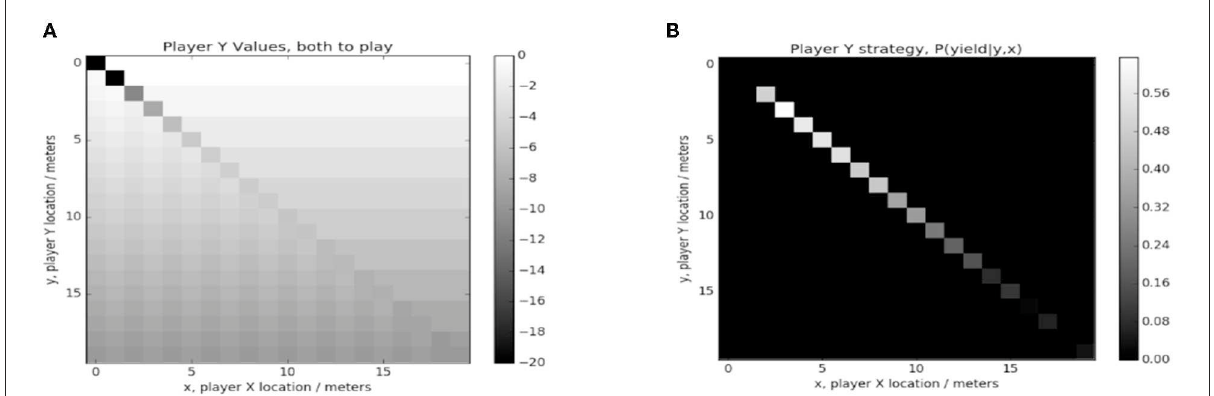
FIGURE4 (A) Value function for player Y over agent joint distance ( x , y ) states up to 20 meters of each agent from the collision point. All values are negative as they include components from cost of time needed to reach the destination and the risk of collision occurring. The collision state x = y = 0 is shown in the top left and has the worst value. Player Y arriving at their destination occurs along the rest of y = 0 and has the best value. (B) Player Y’s strategy over agent joint distance ( x , y ) states up to 20 meters of each agent from the collision point. For each state, Y ’s best strategy is to yield to Player X (i.e., slow down) with the probability shown. The interesting cases are along the diagonal where a negotiation must occur, and it can be seen that the yield probability ramps up as distance to collision